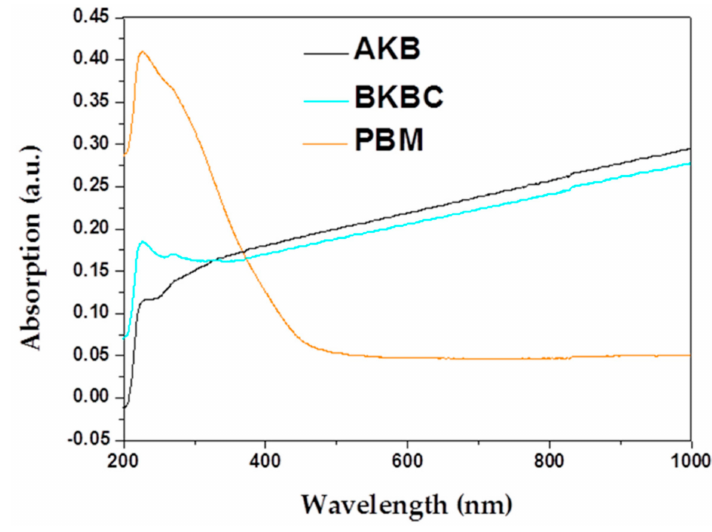
Figure 5. UV-Vis diffuse reflectance spectra of AKB, BKBC, and PBM.